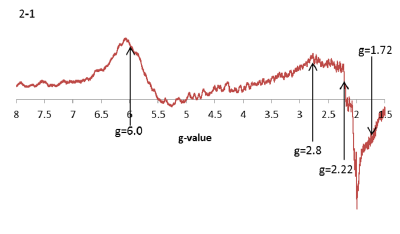
Figure 3. UV–vis absorption spectra of HasApf (40 μ M)/ rac ‐ 2 (0.8 mM)/deionized water (5.0 mL); absorption was monitored at 410 nm (heme) and 350 nm (product ketone ‐ 2) (H) at incubation times of 0, 24, 48, and 72 h.